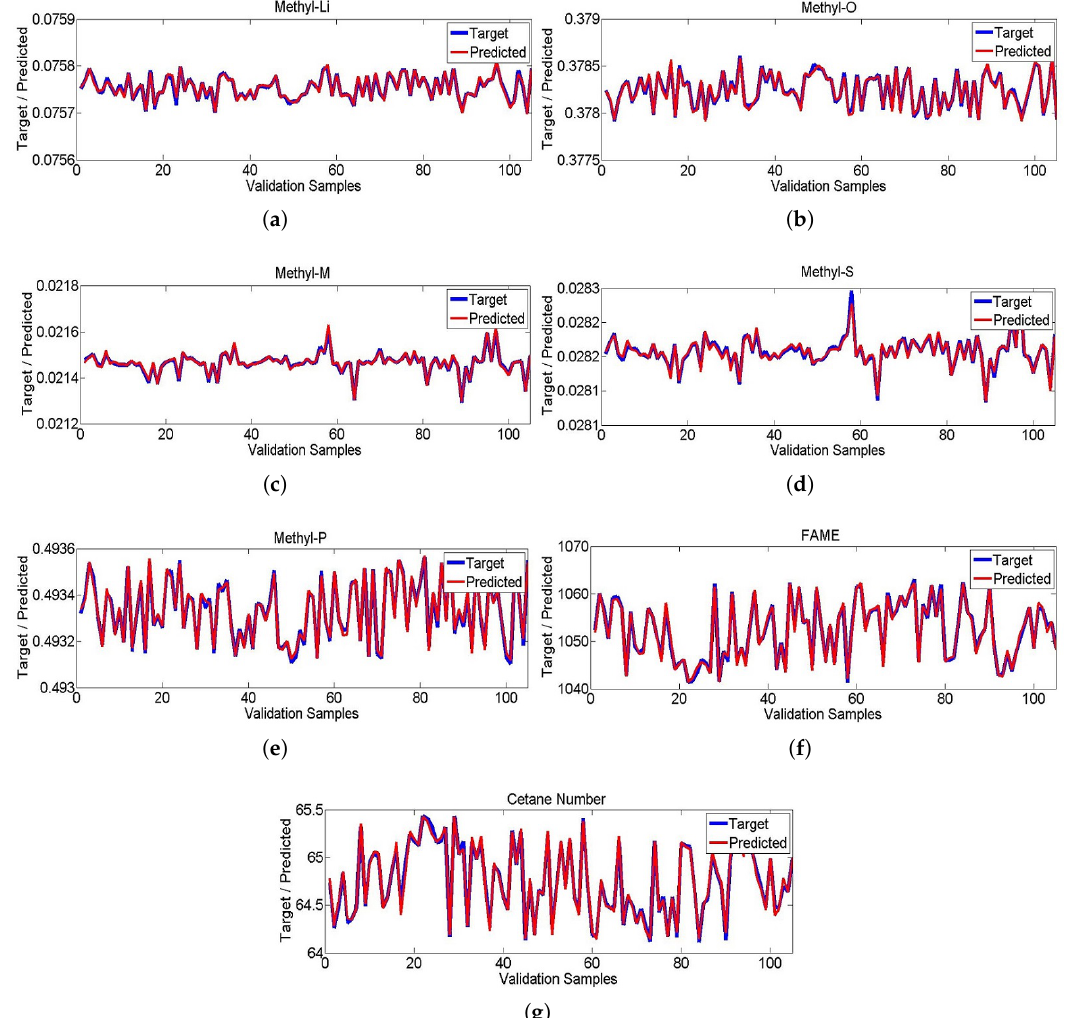
Figure 6. ( a – g ) Target and predicted values of Methyl-Li, Methyl-O, Methyl-M, Methyl-S, Methyl-P, Fame and Cetane